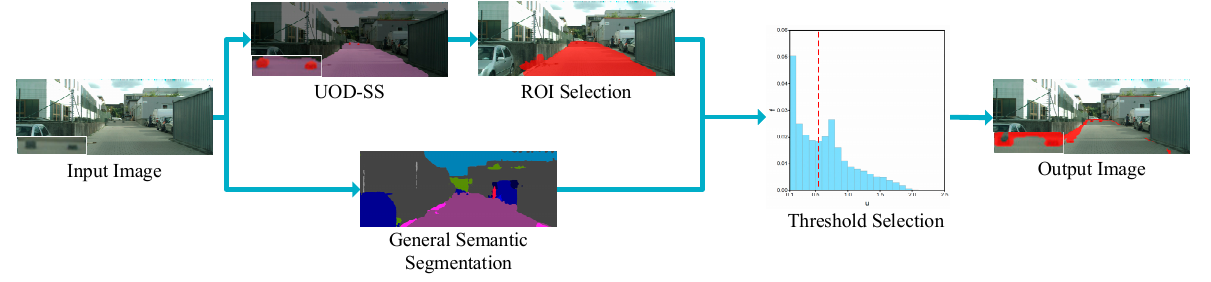
Figure 5. The flow chart of UOD-Un.